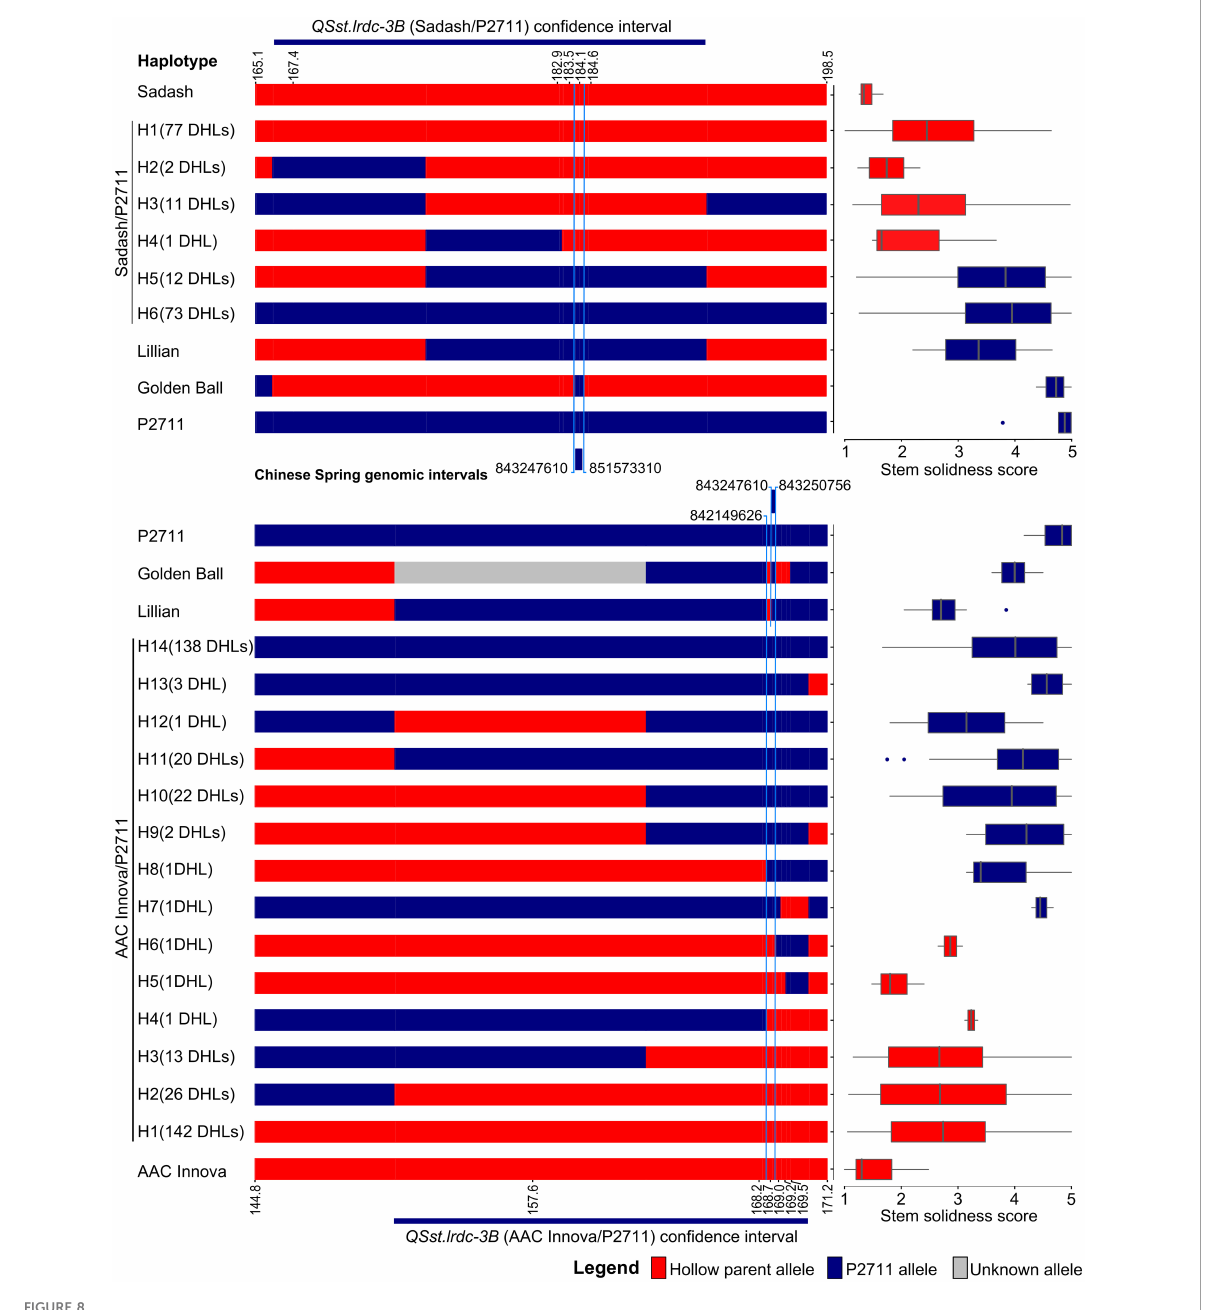
FIGURE 8 Graphical genotypes of wheat haplotypes (H) of doubled haploid lines (DHLs), hollow (Sadash and ‘ AAC Innova ’ )- and solid (P2711)-stem parents, and solid-stem check cultivars (Lillian and ‘ Golden Ball ’ ) displaying recombination breakpoints in the QTL region QSst.lrdc-3B on linkage group 3B. Boxplots showing mean stem solidness score distribution across environments for respective haplotypes. QTL segments marked by blue color lines completely co-segregate with stem